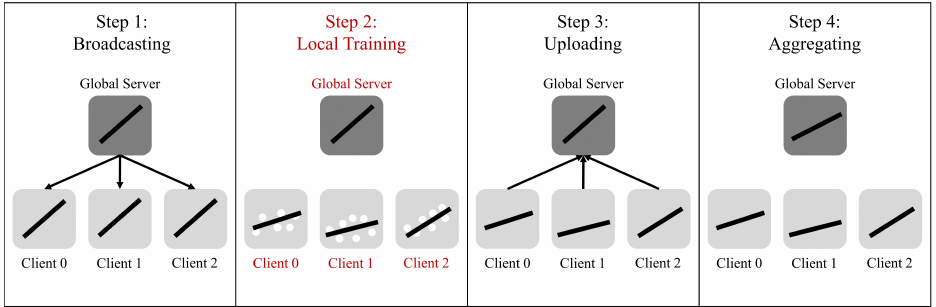
Figure 1. The typical steps of Federated Learning